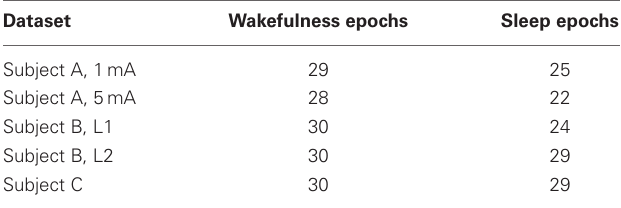
Table 1 | Number of non-outlying epochs used in